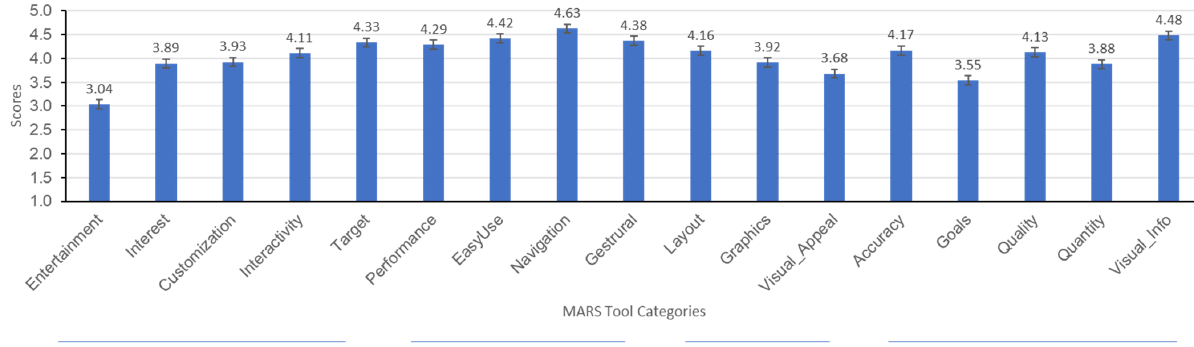
Figure 3. MARS Tool category